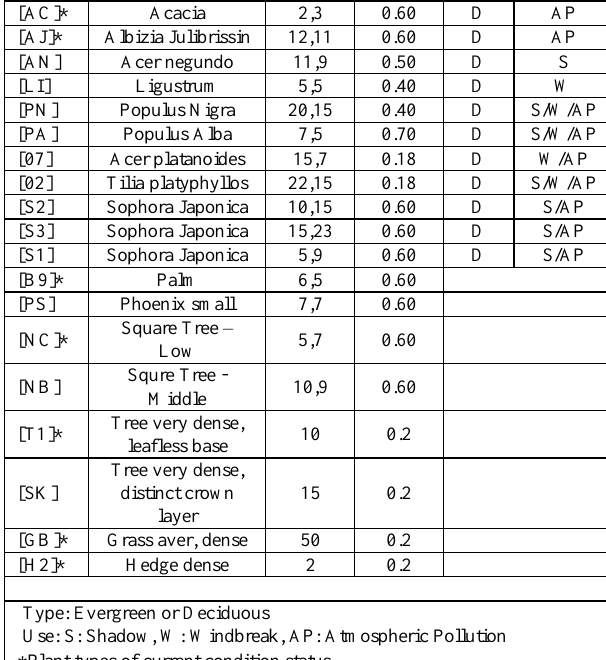
Table 4: Types of Vegetation scenarios